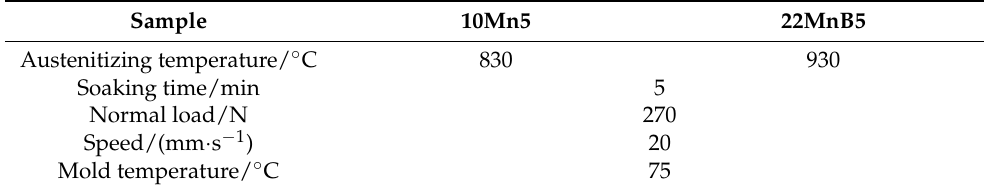
Table 2. High-temperature friction test-specific